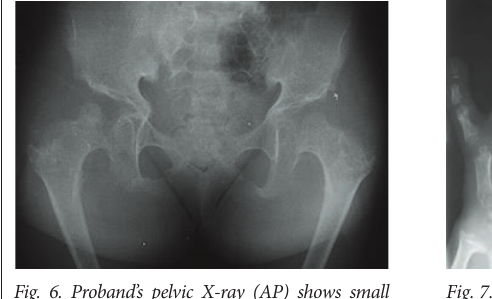
Fig. 6. Proband’s pelvic X-ray (AP) shows small capital femoral epiphyses, short femoral necks, and irregular flared femoral metaphyseal borders and poorly modelled acetabulae with irregular margins.